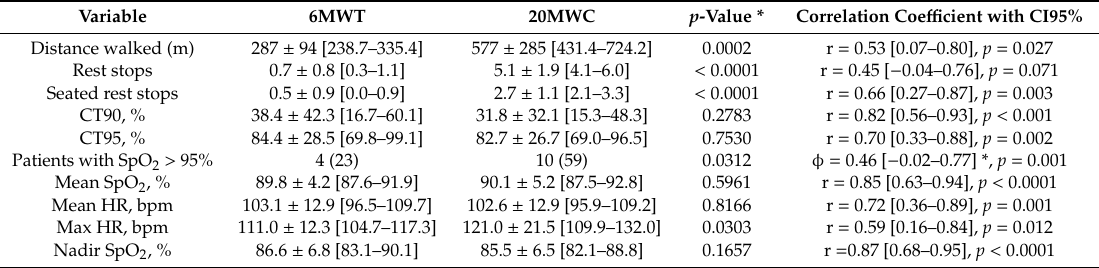
Table 2. Physiologicalandperformancevariablesduringthe6-minutewalktest(6MWT)andthe20-minute walk circuit (20MWC). Values are expressed as mean ± standard deviation, with 95% confidence interval in brackets. Categorical variables were described as number and percentage. CT90: cumulative time with SpO 2 < 90%; CT95: cumulative time with SpO 2 < 95%; SpO 2 : arterial oxygen saturation measured